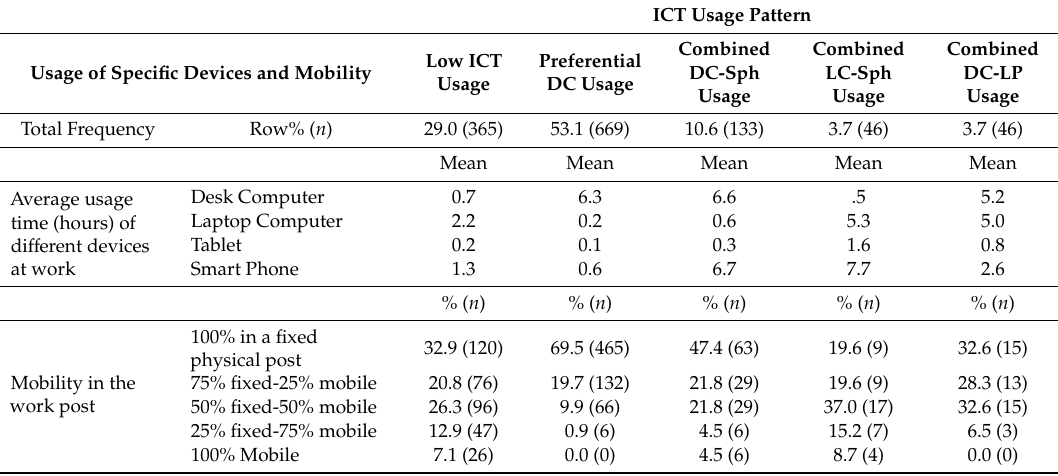
Table 5. ICT Usage Pattern. Cluster analysis